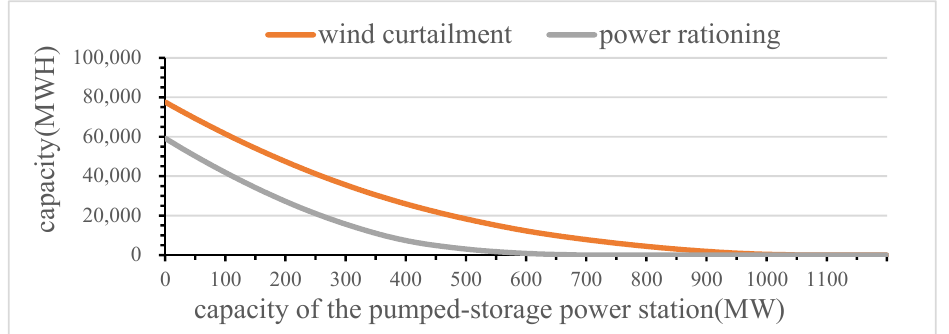
Figure 11. Input capacity and curtailment of wind, power rationing in the peak period of heating.